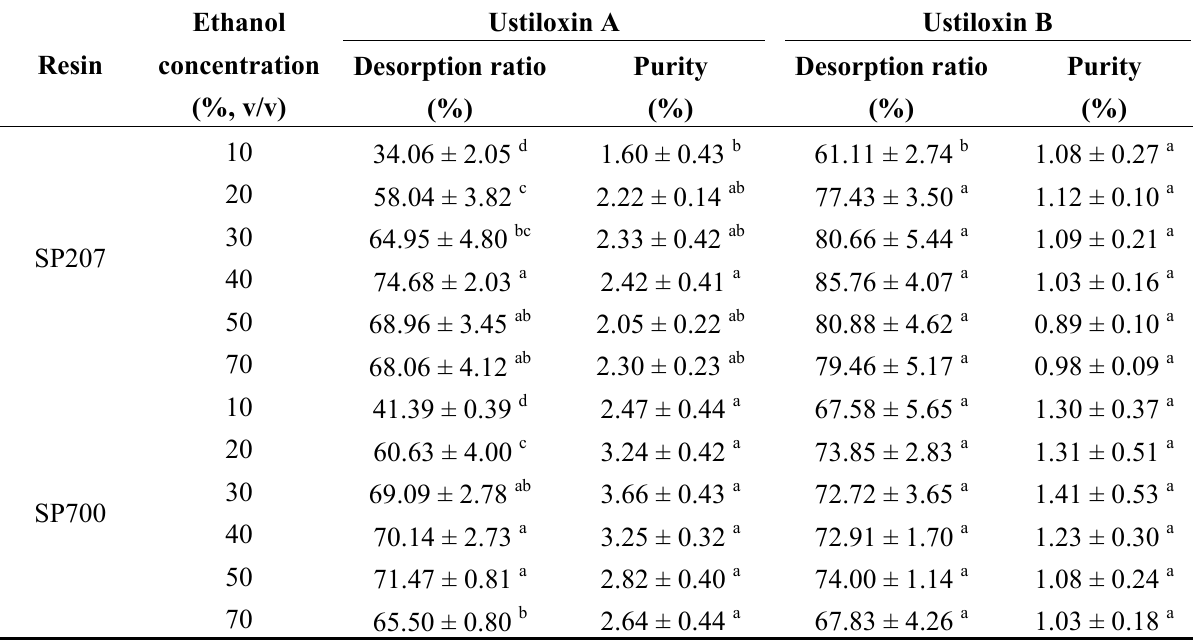
Table 5. Effects of ethanol concentration on desorption ratios of resins SP207 and SP700 along with the purities of ustiloxins A and